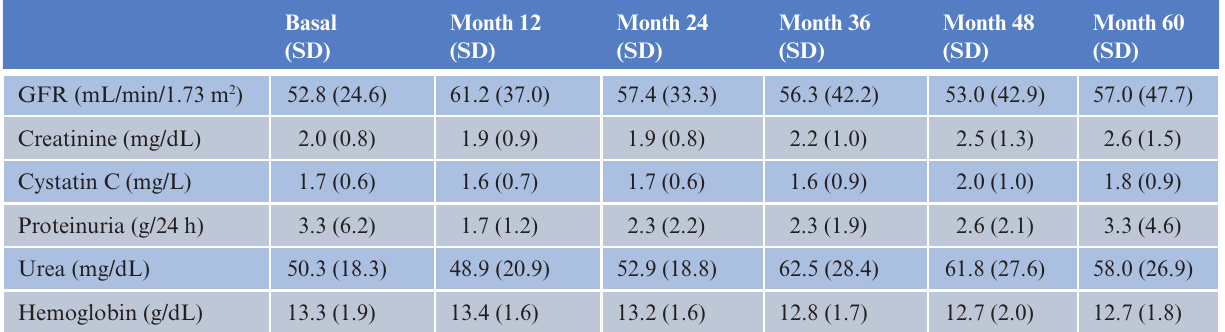
Table 2. ITT analysis of mean laboratory measurements throughout the study.